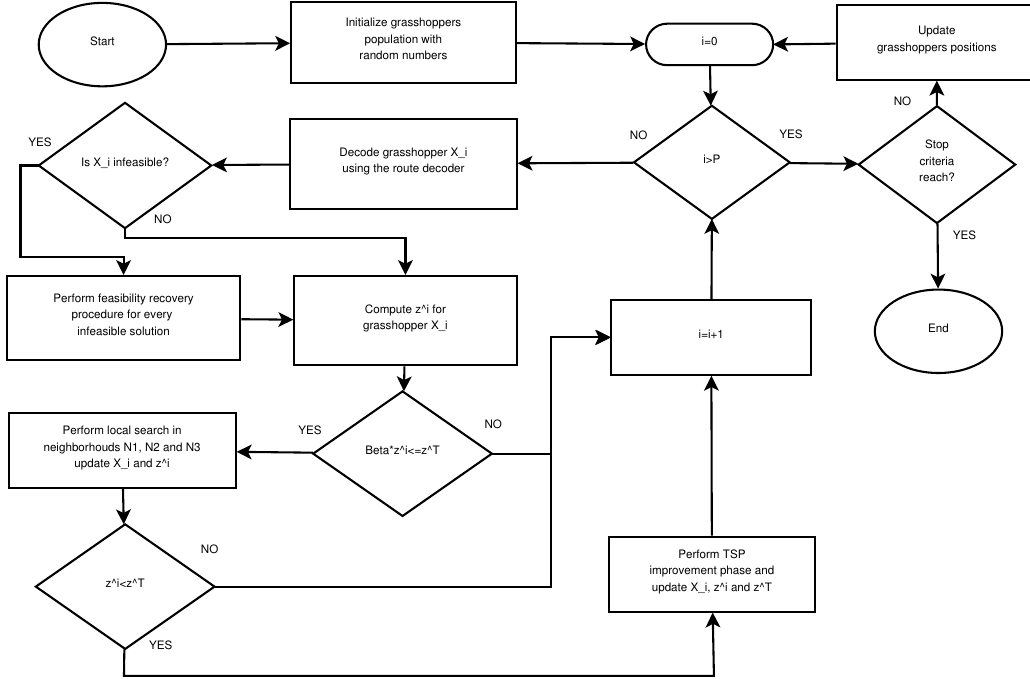
Figure 1. Flow diagram for the hybrid grasshopper optimization algorithm with local search